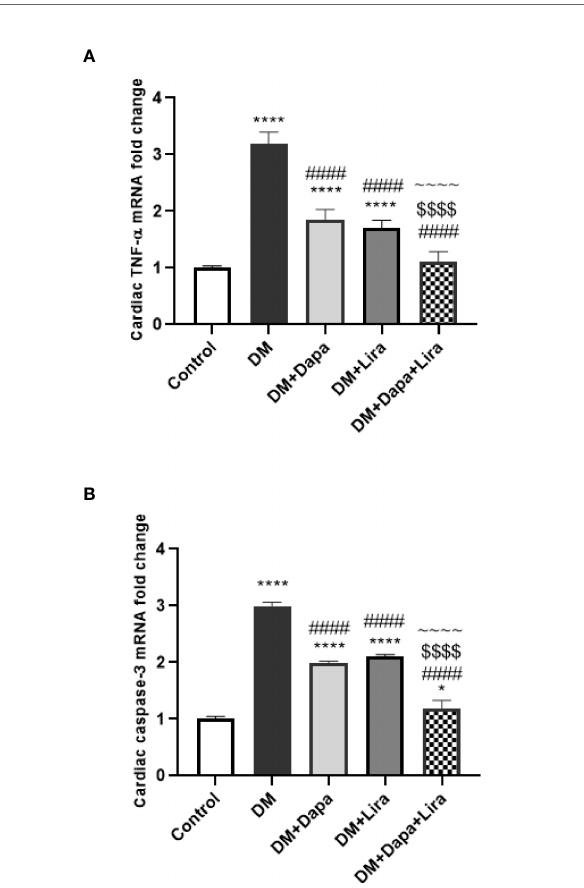
FIGURE 4 | Effect of dapagli fl ozin (Dapa) and liraglutide (Lira) or their combination on mRNA expression of (A) tissue TNF- a and (B) tissue caspase- 3. Data are represented as mean ± SE, n = 5. **** signi fi cance in comparison with control group at p < 0.0001, #### signi fi cance in comparison with diabetic group at p < 0.0001, ~~~~ signi fi cance in comparison with DM+Dapa at p < 0.0001, $$$$ signi fi cance in comparison with DM+Lira group at p < 0.0001.